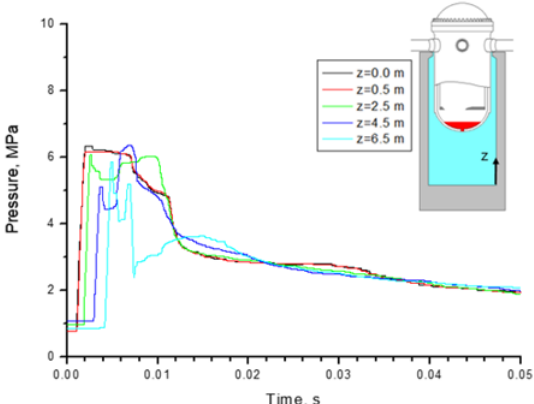
Figure 5. Steam explosion pressure history for different heights derived from the TRACER-II.